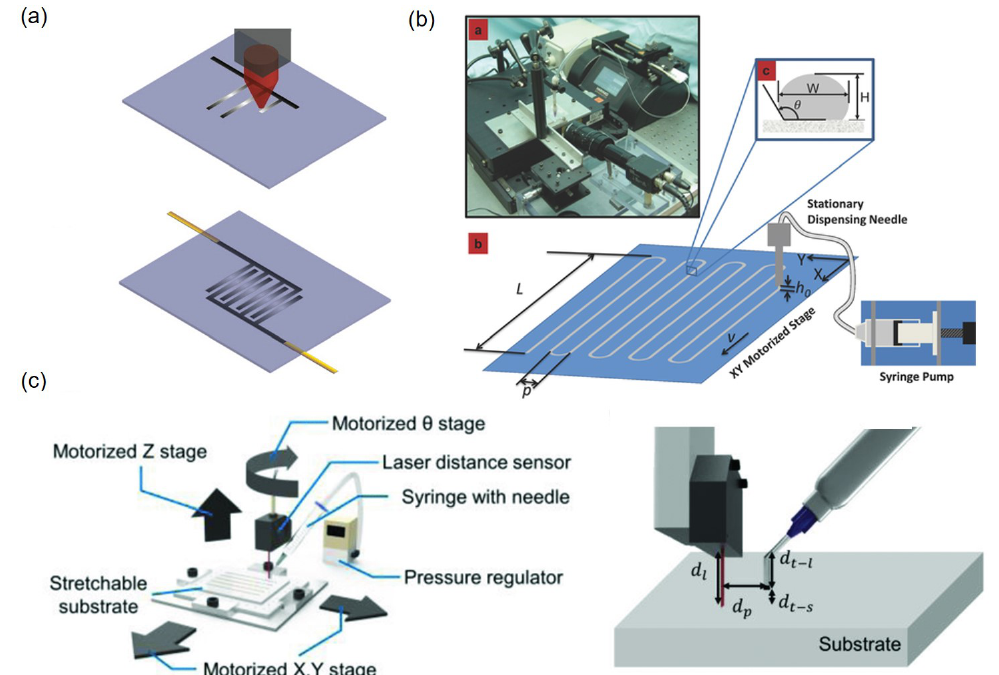
Figure 3. ( a ) Schematic of liquid metal printing using tip that is immersed in liquid metals. After applying liquid metals to the tip, successive droplets are deposited on the substrate and the droplets are merged to form a pattern. Reprinted with permission from [48]. Copyright (2013) American Chemical Society. ( b ) Schematic and photographs of direct printing using motorized stage with syringe pump. The syringe pump discharges the liquid metal and the motorized stage moves to make shape of the pattern. Reproduced with permission from [49]; published by John Wiley and Sons, 2014. ( c ) Schematic of the four-degree-of-freedom liquid metal direct printing. Based on the distance measured from the laser sensor, the distance feedback system allows the distance to be kept constant between the tip and the substrate. Reproduced with permission from [51]; published by John Wiley and Sons,